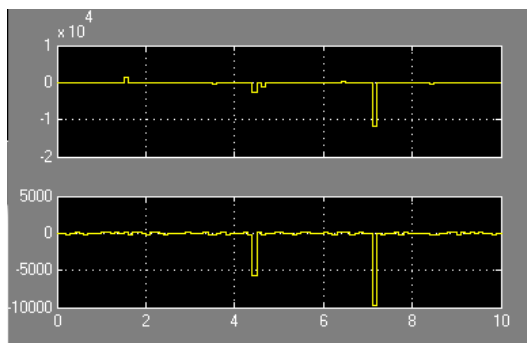
Figure 9. model with using ANN of Scope 2 ‘G 4 (u)’